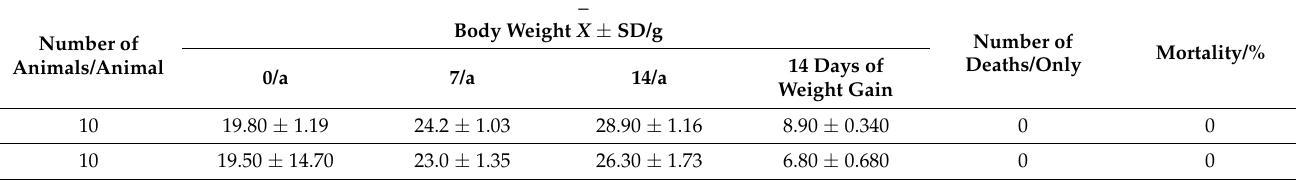
Table 3. Acute oral toxicity test results.